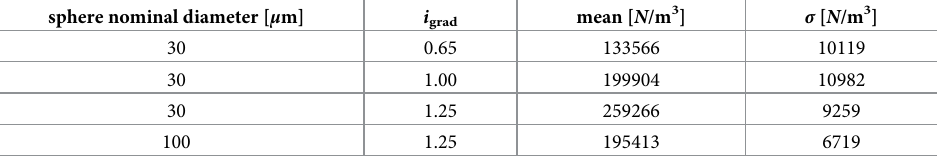
Table 1. Calibration in respect to volumetric force ( ^ F dard deviation values ( σ ).